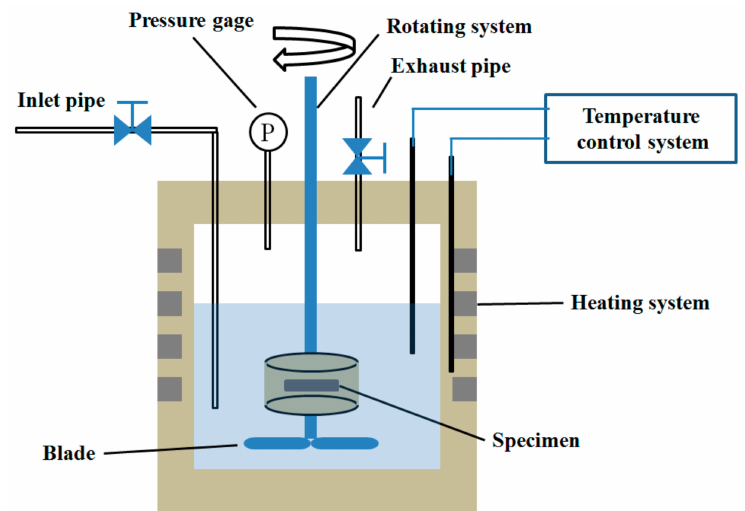
Figure 1. Schematic diagram of the HTHPE.